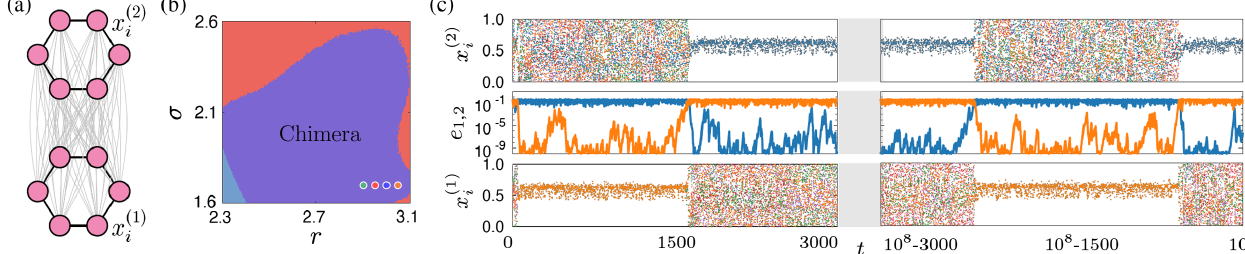
FIG. 1. Globally attractive chimera state whose coherent and incoherent clusters switch under extremely small noise. (a) Network system, formed by two rings of logistic maps mutually coupled through weaker links [Eq. (1)]. (b) Parameter space color coded according to the linear stability of the possible states, namely, whether both rings can synchronize (cyan), only one ring can synchronize (purple), or neither ring can synchronize (red). The four dots mark the parameters used in Fig. 2. (c) Direct simulation of the system for σ ¼ 1 . 7 and r ¼ 3 . 05 [orange dot in (b)] for noise intensity ξ ¼ 10 − 10 , illustrating the dynamics of a switching chimera. The top and bottom show the oscillator states in each of the two rings (color coded by oscillator, where single-color segments indicate synchronization), while the center shows the synchronization error [defined in Eq. (2)] in each ring color coded